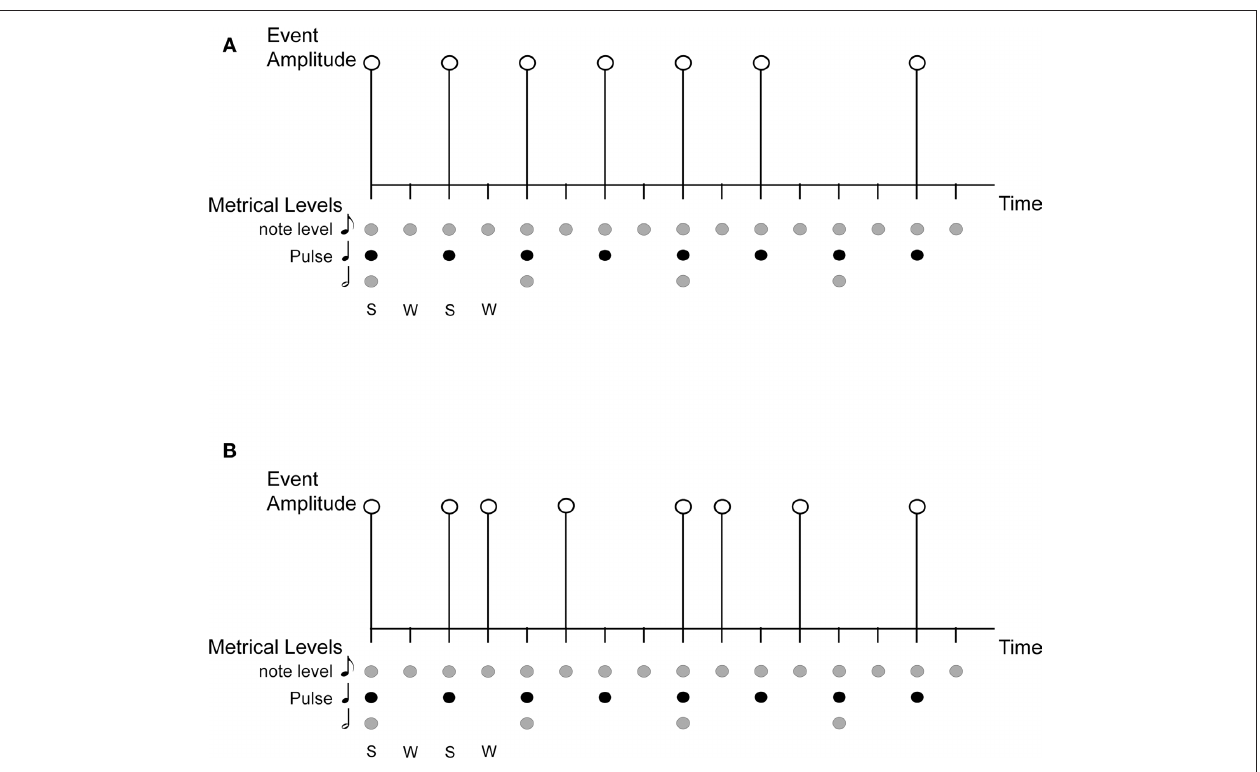
FIguRe 1 | An illustration of the concepts of rhythm, beat, pulse, meter, and syncopation. S, Strong beat; W, Weak beat; (A) is a simple rhythm on a grid showing metrical structure and accent, with 16 beats at the eighth-note metrical level, eight (strong) beats at the quarter-note level (the pulse), and four